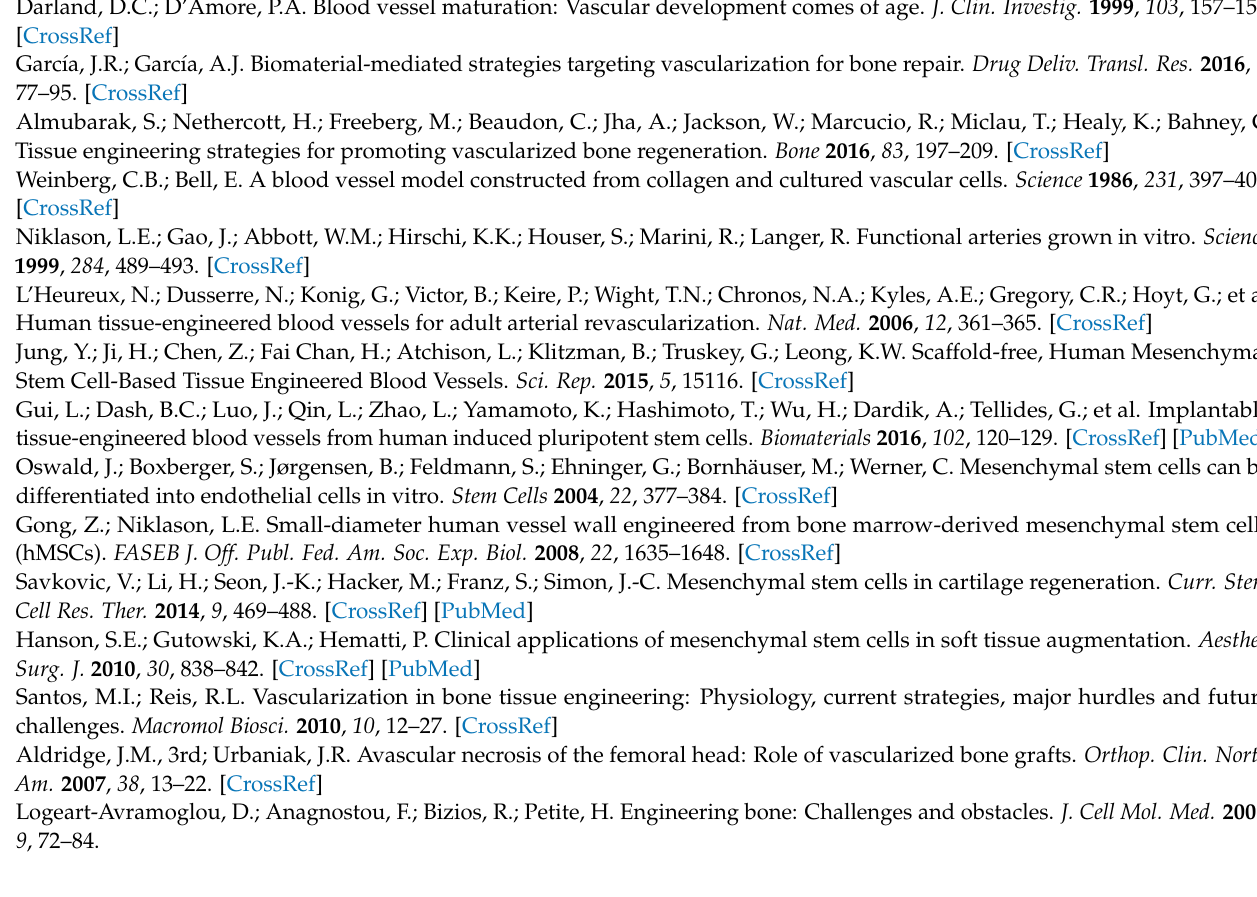
Table S1: Medium Compositions; Table S2: Primer